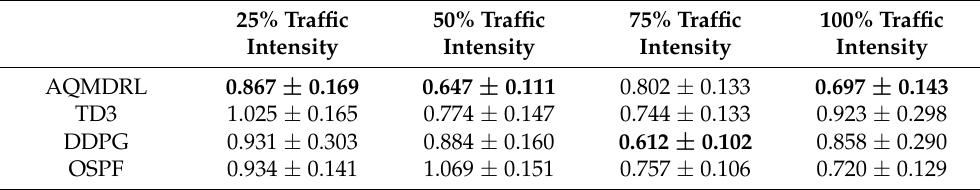
Table 3. Comparison of average load-balancing coefficient in different traffic intensities.